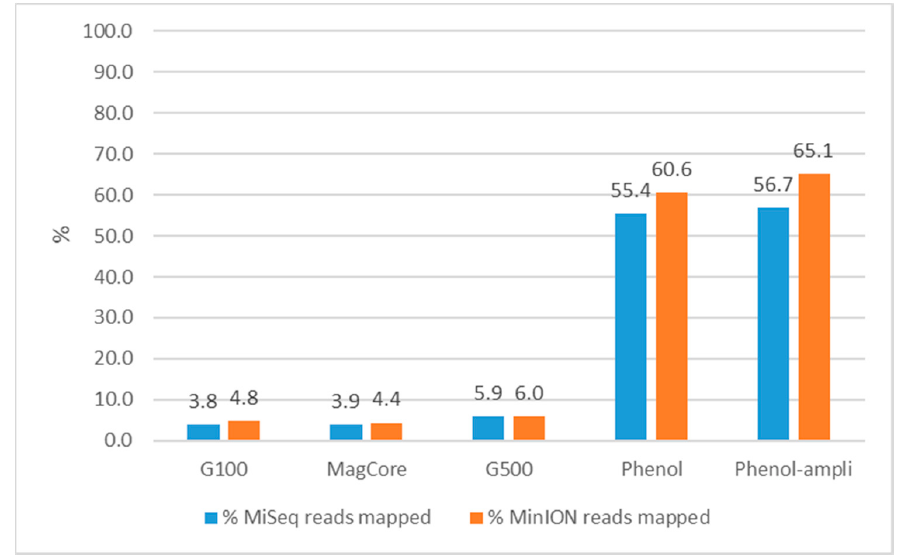
Figure 4. Percentage of MiSeq and MinION reads from the G100 (extr-3), MagCore (extr-4), G500 (extr-5), phenol (extr-7) and phenol-ampli (extr-8) DNA extractions of Salmonella isolate S15BD05371 mapped to the complete plasmid